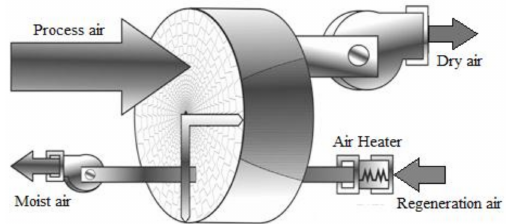
Figure 1. Rotary Desiccant Dehumidification